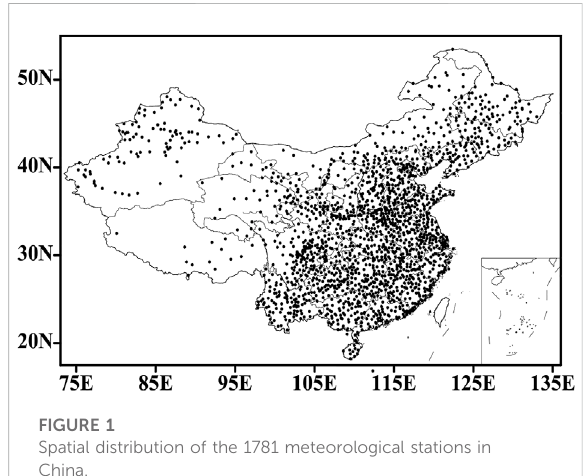
FIGURE 1 Spatial distribution of the 1781 meteorological stations